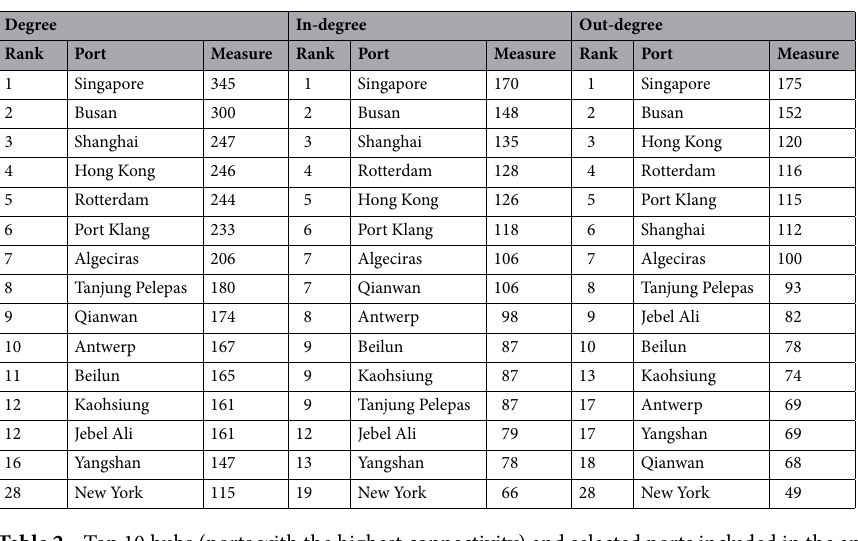
Table 2. Top 10 hubs (ports with the highest connectivity) and selected ports included in the analysis of the GCSN.